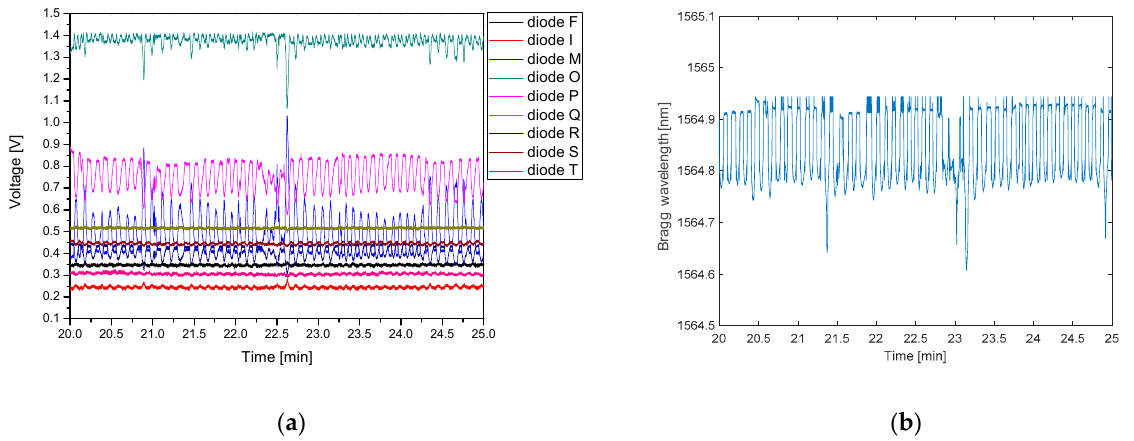
Figure 13. Previous measurement close-up with breath results captured by ( a ) PIC interrogator; ( b ) Ibsen I-MON 256 interrogator.